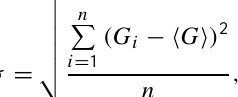
Submitted to Annales Geophysicae , November 22, 2006; revised December 13, 2007.